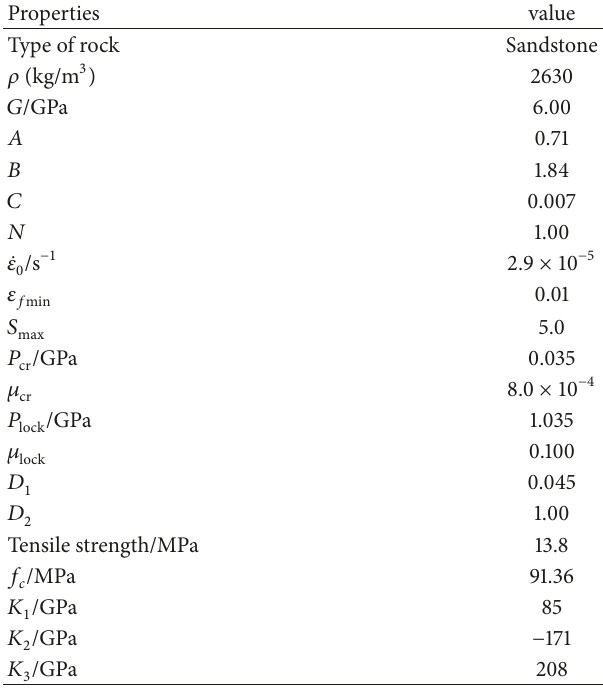
Table 1: Mechanical properties of the